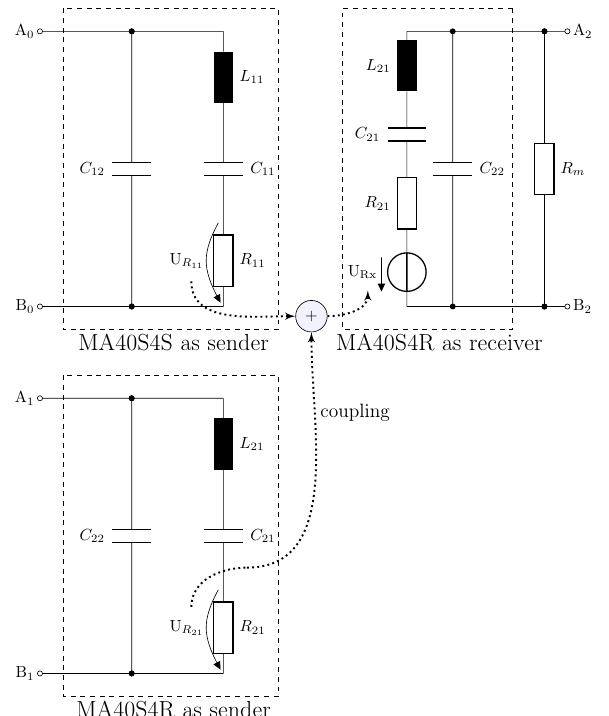
Figure 2. Equivalent circuit of the piezoelectric ultrasound senders (left) and receiver (right) with measurement resistor R m . The sender (MA40S4S) and receiver (MA40S4R) pair are both used as senders and only the receiver is used for the reception. The voltage at re- sistor R 11 and R 21 at the senders is directly coupled to the voltage source at the receiver as the received signal voltage U R x